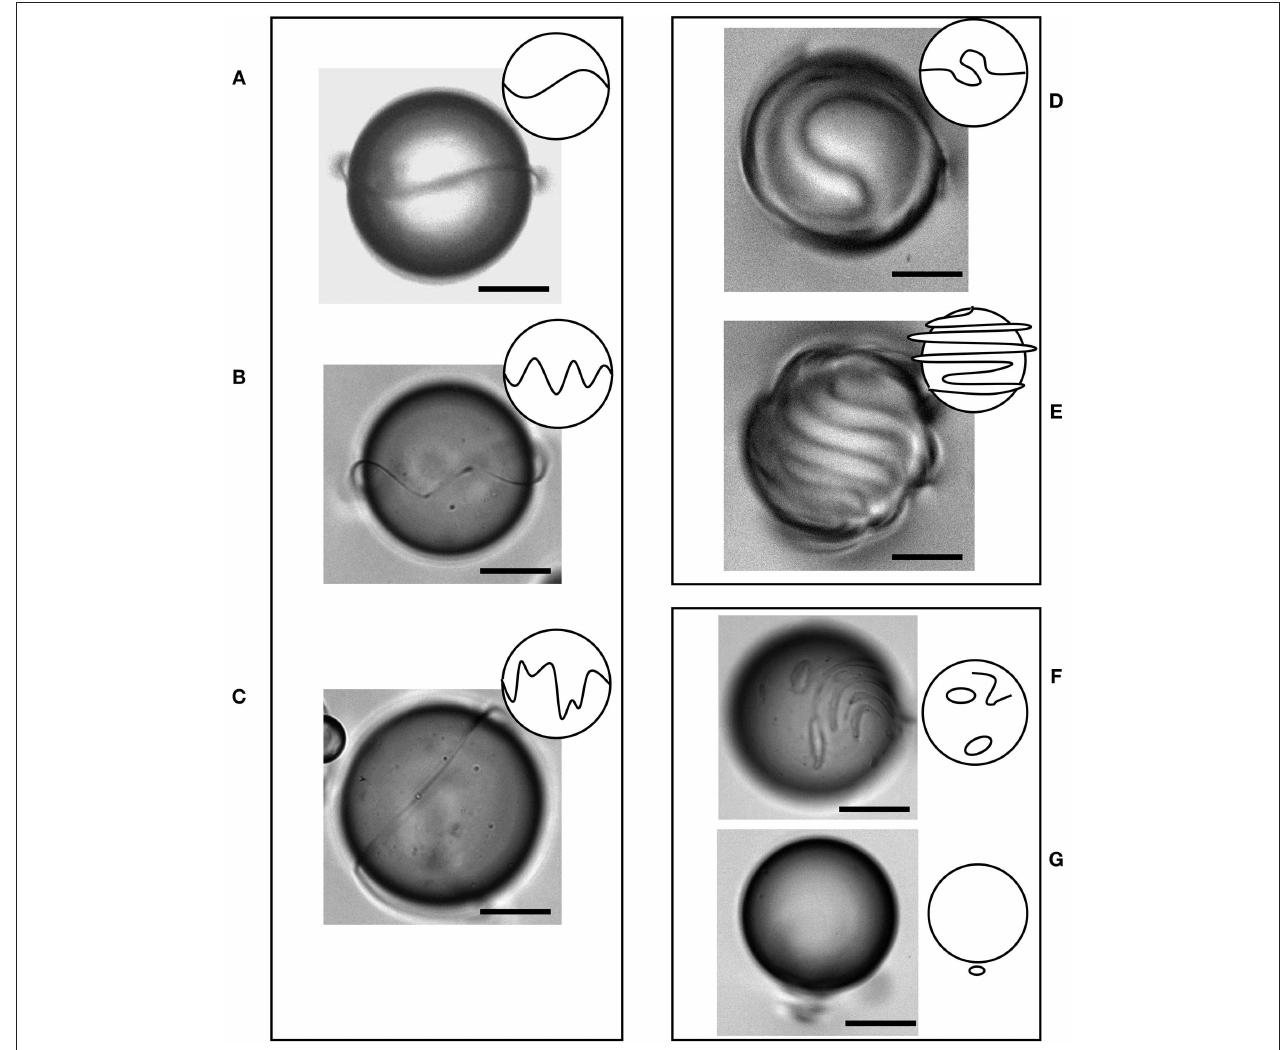
FIGURE 3 | Different dynamic structures of the perturbed Saturn Rings. Sketches on the left and micrographs on the right are included with each case. (A) Single mode ( m = 2) synchronous oscillations. (B) Multi-mode synchronous oscillations. (C) Multi-mode asynchronous oscillations. (D) Multi-valued single wrapping of the SR. (E) Multi-valued multiple wrapping of the SR. (F) SR has fragmented into multiple disconnected disclinations and loops. (G) SR has collapsed into a point defect to the South of the droplet. Scale bars, 20 µ